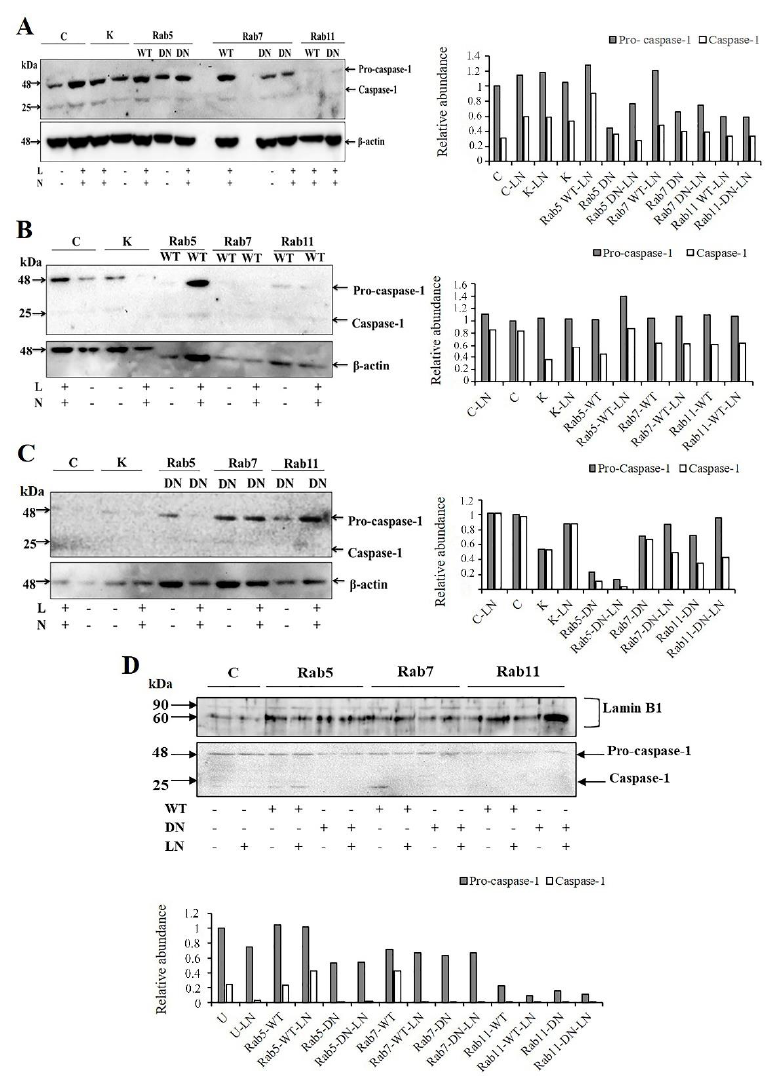
Figure 8. The effects of LPS/nigericin treatment on the expression of pro-caspase-1 and caspase-1 in Rab5-WT, Rab5-DN, Rab7-WT, Rab7-DN, Rab11-WT and Rab11DN cells. Nigericin (20 µM) treatment for 24 hours and three hours of pre-incubation with LPS (1 µg/ml) were used to activate the NALP3 inflammasome after the transfection of pDsRed-rab5-WT, pDsRed-rab5-DN, pDsRed-rab7-WT, pDsRed-rab7-DN, pDsRed-rab11-WT and pDsRed-rab11-DN to the HCT116 cells. ( A ) Whole cell lysates were immunoblotted with caspase 1 and β -actin antibodies. ( B ) Cytosolic fractions of Rab5-WT, Rab7-WT and Rab11-WT cells were immunoblotted with caspase 1 and β -actin antibodies. ( C ) Cytosolic fractions of Rab5-DN, Rab7-DN and Rab11-DN cells were immunoblotted with caspase 1 and β -actin antibodies. ( D ) Nuclear fractions of Rab5-WT, Rab5-DN, Rab7-WT, Rab7-DN, Rab11 WT and Rab11-DN cells were immunoblotted with caspase 1 and Lamin B antibodies. The density of protein bands was measured using ImageJ software. C: Non-transfected HCT-116, control cells, K: Katushka2S transfected cells; WT: wild type; DN: dominant negative; L: LPS; N: nigericin; LN: LPS /